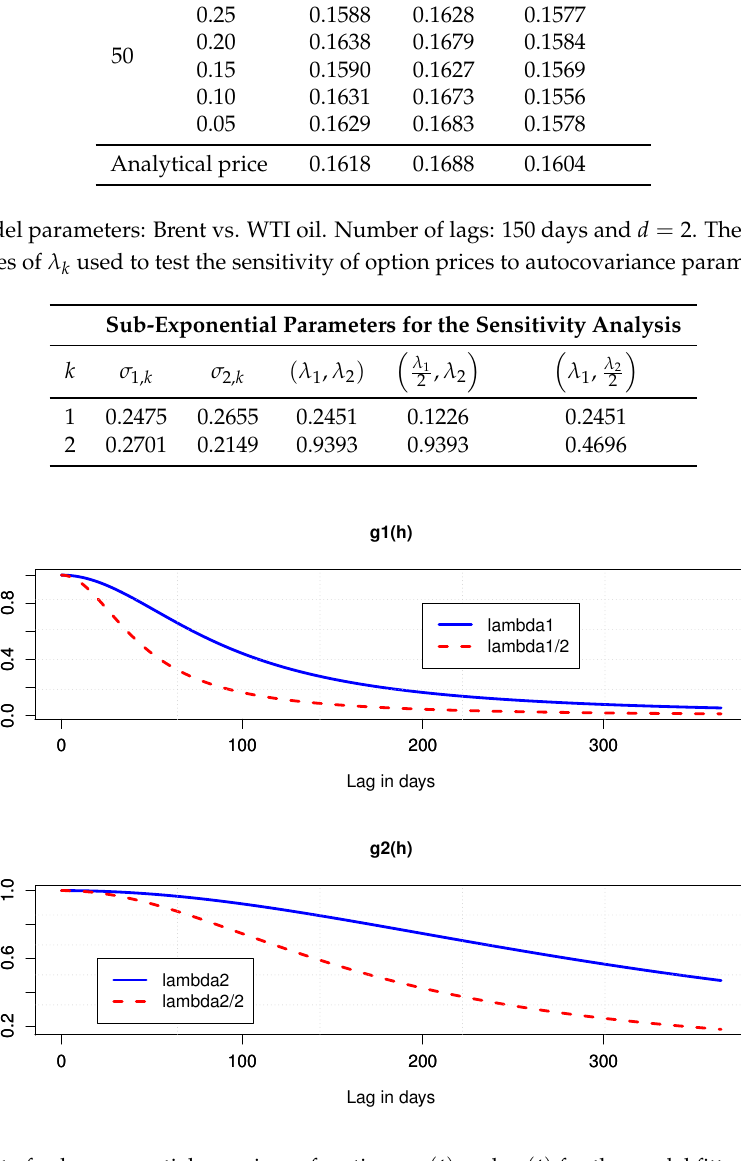
Figure 2. Plot of sub-exponential covariance functions g 1 ( t ) and g 2 ( t ) for the model fitted to Brent and WTI oil log-returns with d = 2. Parameters λ 1 and λ 2 are reported in Table